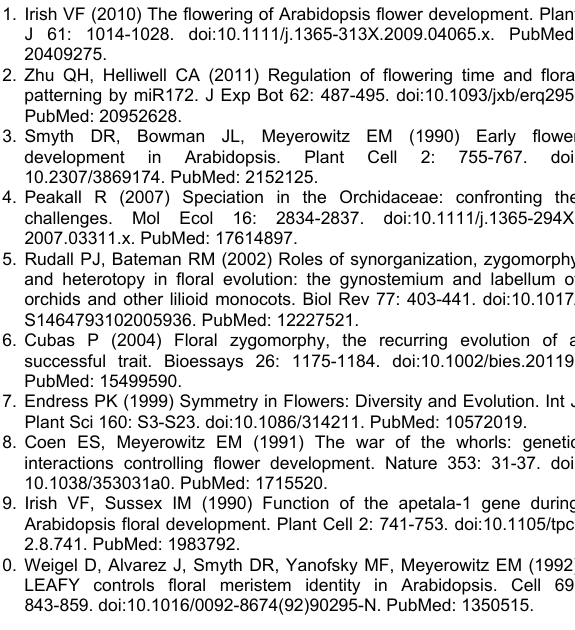
scatter plot. Table S1. Top 20 genes differentially expressed in specific tissues. Figure S2. Quantitative PCR validation of genes differentially expressed in specific tissues. Table S2. Genes from the microarray clustering assay that were validated by quantitative PCR.Table S3. List of primers used for quantitative PCR analysis. Figure S3. Phylogenetic analysis of MADS box genes and AP2 genes. Table S4. MADS box genes and AP2 genes in phylogenetic analysis. Figure S4. Subcellular localization of MADS box genes according to particle bombardment. Figure S5. Peloric flowers of